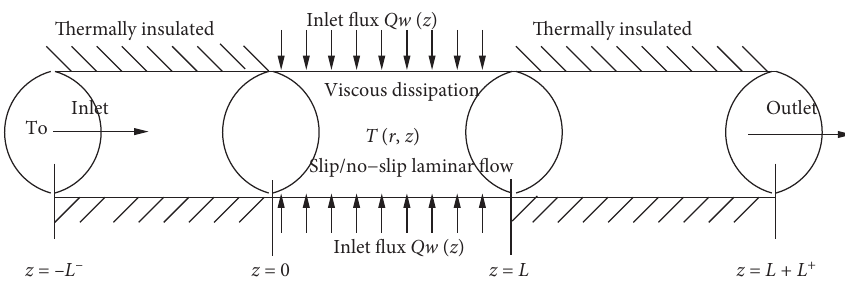
Figure 1: Schematic representation of the physical domain and boundary